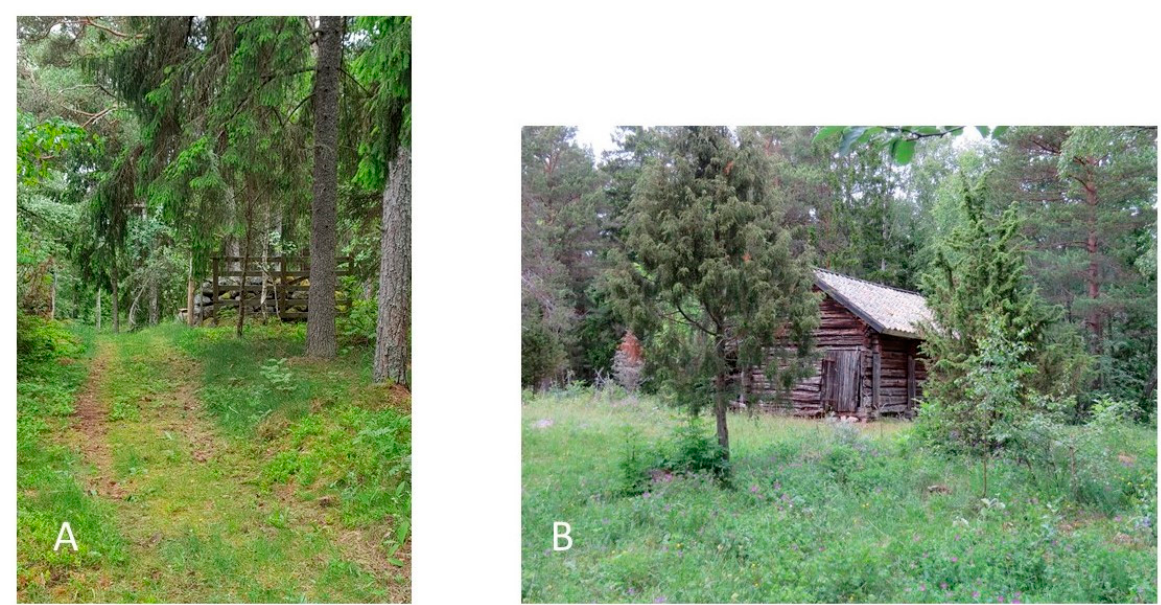
Figure 1. The background of floristic legacies in boreo-nemoral forests. ( A ) A gate in a stone wall enclosing a former hay-meadow on Singö, province of Uppland, Sweden. Forest grazing was conducted in the foreground of the gate and the stone wall. The site is slowly reverting back to forest. ( B ) An old storage building for hay in the meadow enclosed by the stone-wall in ( A ). The grass sward still maintains a rich grassland flora. (Photos: the author, July 2022).